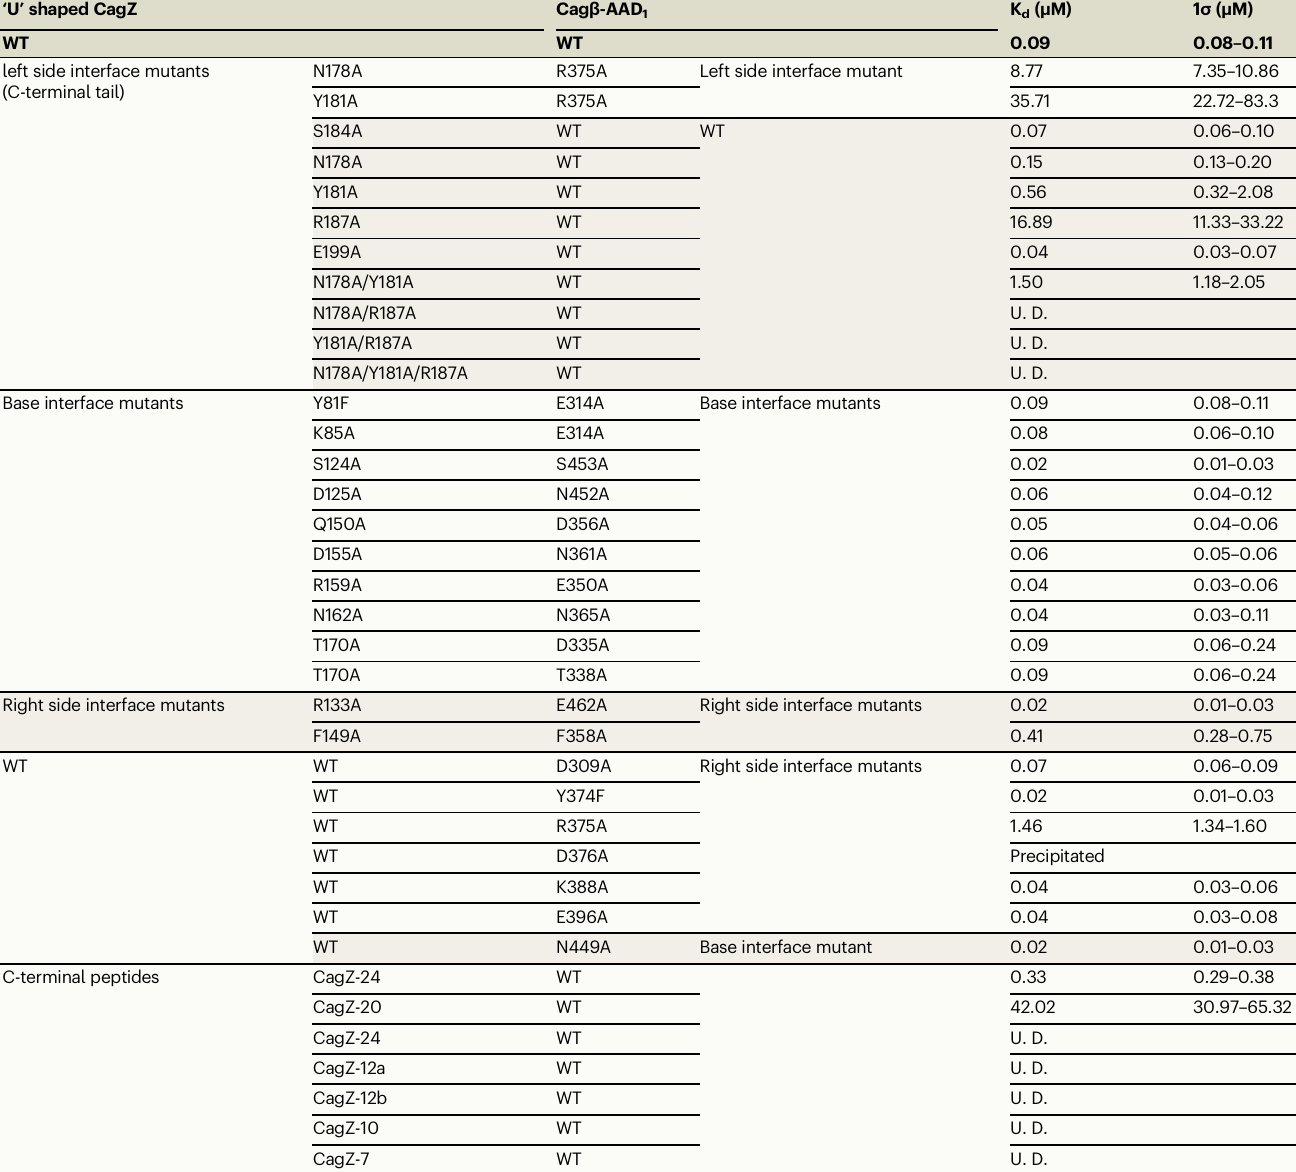
Table 1 | Dissociation constants derived from isothermal titration calorimetry ‘ U ’ shaped